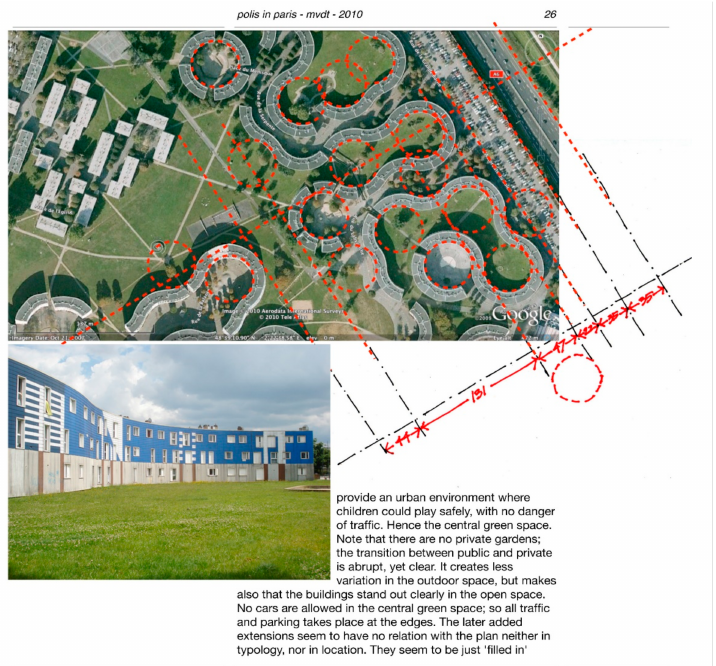
Figure 20. Excursion to Paris and surroundings by Delft town planning students in 2010; working out size, scale, and proportions from Google Earth map [16].